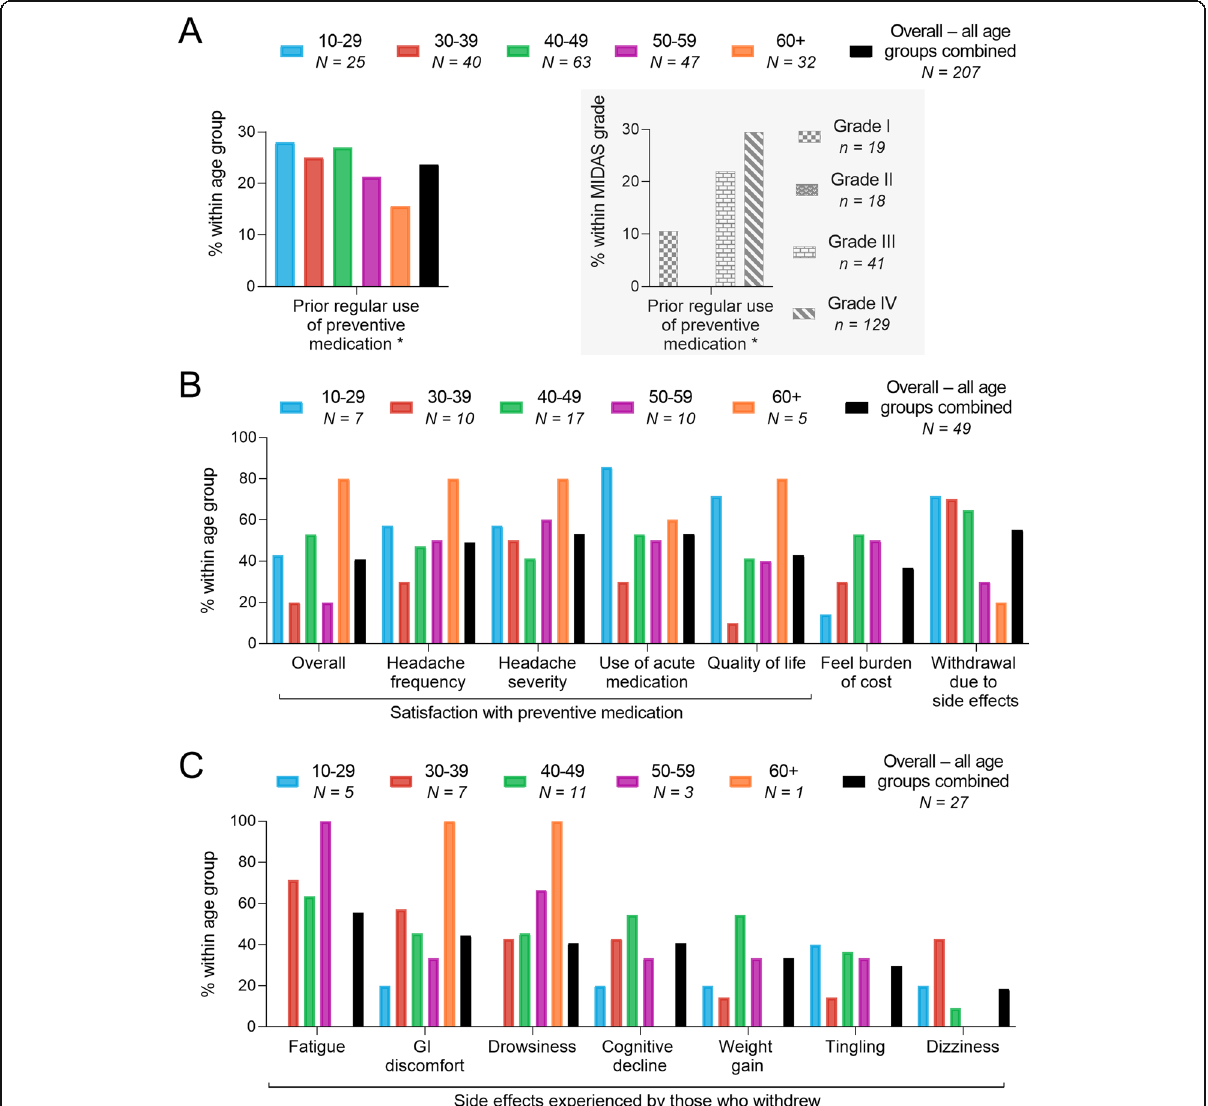
Fig. 3 Past experience with preventive medication for migraine. Results for ( a ) prior regular use of preventive medication, ( b ) satisfaction with preventive medication, burden of cost, and withdrawal due to side effects, and ( c ) side effects experienced by those who withdrew are presented for each age group (and MIDAS grade group in (A)) and for overall respondents, the latter inclusive of all age groups. Results are presented as percentage of respondents. MIDAS = Migraine Disability Assessment; GI = Gastro-intestinal; N = Number of patients. * Respondents who did not take preventive medication regularly only took it when they were experiencing a headache. Those who took preventive medication regularly did so